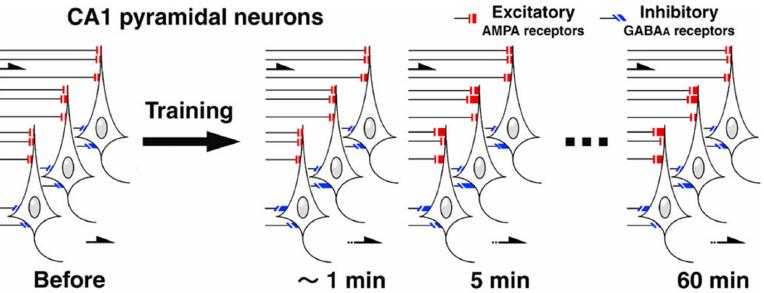
Figure 1. Schematic image of CA1 pyramidal neurons. IA training rapidly strengthened GABA A receptor-mediated inhibitory synapses within 1 min, while the training strengthened AMPA receptor-mediated excitatory synapses within 5 min. CA1 pyramidal neurons exhibited broad diversity of excitatory/inhibitory synaptic currents within 5 min, and the neuron-specific synaptic diversity was sustained for more than 60 min. A possible causal relationship between GABAergic plasticity and learning has been previously reported. Genetic deficiency of GABA A R β 3 severely impairs the contextual freezing response without affecting pain perception [30], and phosphorylation in the cy- toplasmic loop of the β 3 subunit (Ser 408–409 ) is known to play an essential role for PKA, PKB, PKC, Ca 2+ and calmodulin-dependent protein kinase II-dependent plasticity [31], as phos- phorylation can increase surface levels of GABA A receptors containing β 3 subunits in cul- tured neurons (Figure 2) [32–35]. Not only the genetic deficiency of GABA A R β 3, but also prevention of GABA A receptor-mediated plasticity in CA1 impairs contextual learning [10,30]. Optogenetic manipulation of CA1 neurons further proved the timing-specific causal relationship between GABAergic inputs and learning; optic inactivation of den- drite-targeting CA1 interneurons during aversive stimuli was sufficient to prevent fear teaching [11]. In a preliminary study, we found that microinjections of an interference peptide in Ser 408–409 phosphorylation into the CA1 successfully blocked training-induced mIPSC strengthening. Moreover, bilateral peptide microinjections resulted in a drastic de- crease in IA task-learning performance, suggesting further causal relationship between learning and Ser 408–409 phosphorylation of the GABA A R β 3 subunit.